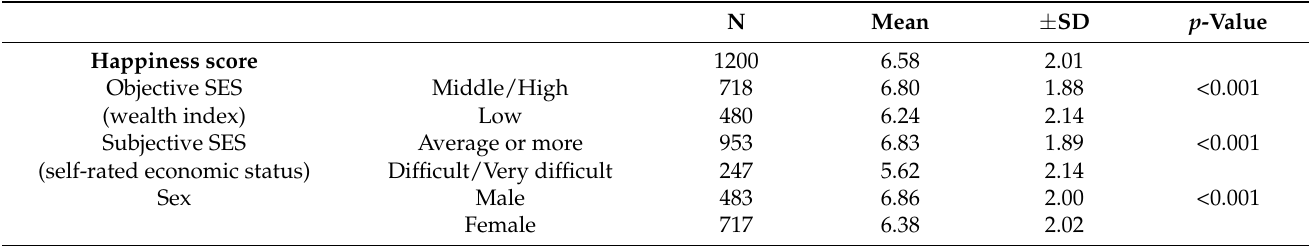
Table 1. Happiness scores by socio-demographic characteristics ( n =